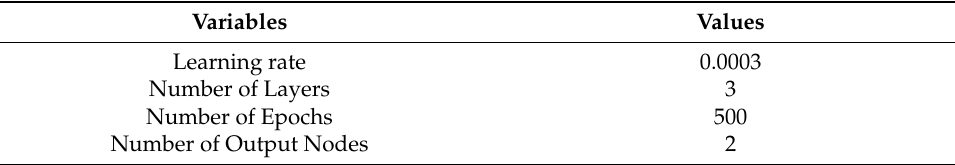
Figure 14. The design of the MDN network applied on BCG Strains dataset. Table 4. Variables of the